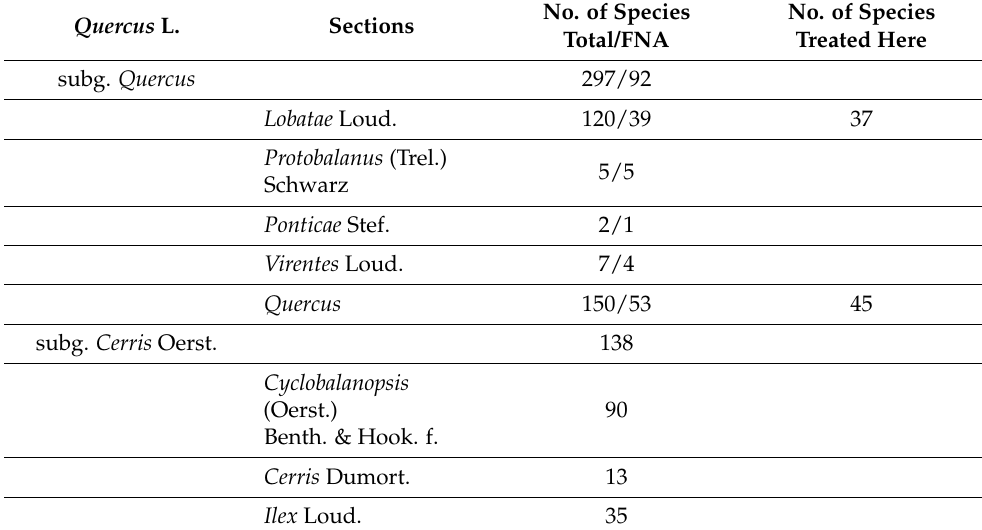
Table 1. Current Infrageneric classification of the genus Quercus [3]. The total number of species with in each infrageneric group is provided, including the number of species within the Flora of North America (FNA) region and the number treated within this study. No. of Species No. of Species Quercus L. Sections Total/FNA Treated Here subg. Quercus 297/92 Lobatae Loud. 120/39 37 Protobalanus (Trel.) 5/5 Schwarz Ponticae Stef. 2/1 Virentes Loud. 7/4 Quercus 150/53 45 subg. Cerris Oerst. 138 Cyclobalanopsis (Oerst.) 90 Benth. & Hook. f. Cerris Dumort. 13 Ilex Loud.